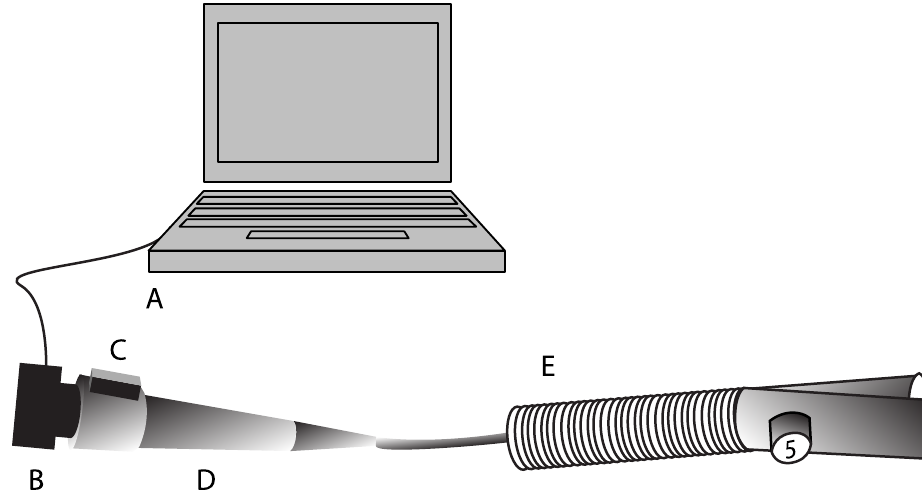
Fig 3. Experimental design of the clinical utility test. Participants reportednumbers printed on papersat the left main, right main, and right upper bronchi of the airway model for both exams with and without using the image orientationcorrection system. The numbersinside the airway model were reset for each test. A, computer; B, charged-coupleddevice (CCD) camera; C, sensor; D, handleof the endoscope; and E, airway model with numbered papers at the left main, right main, and right upper